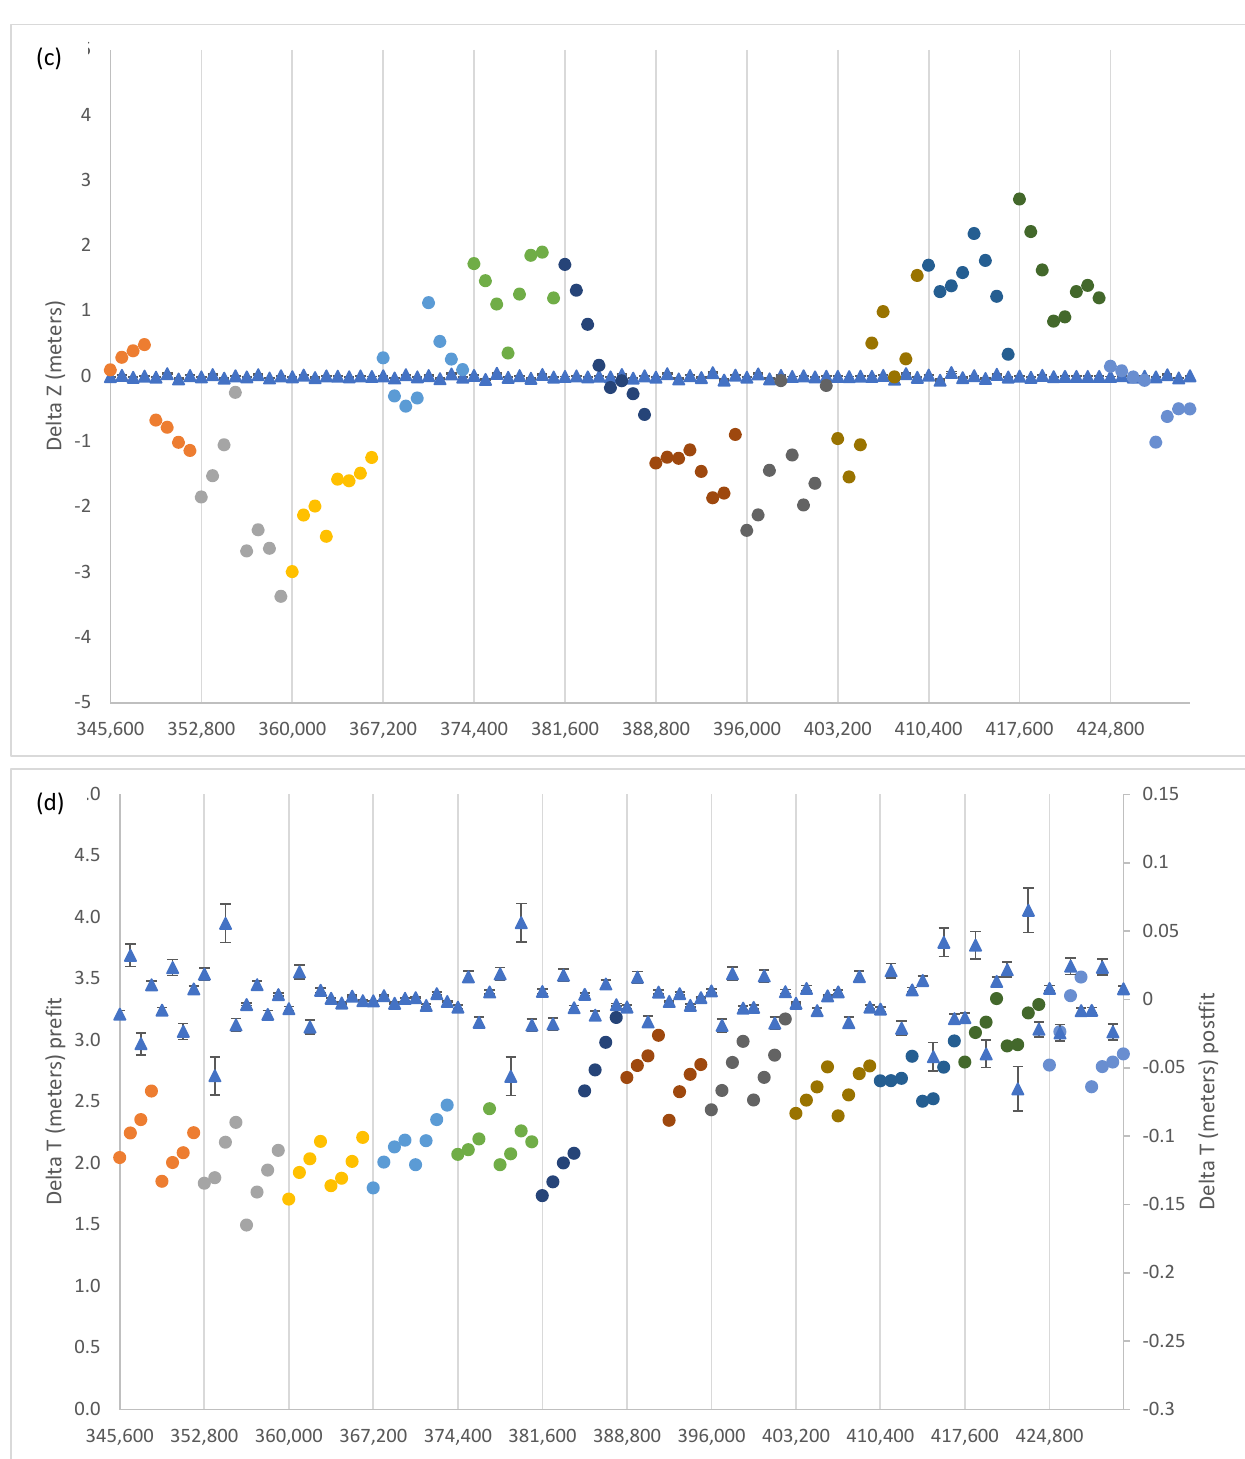
Figure 11. Pre-fit (dots) and post-fit (diamonds) residuals of ( a ) X, ( b ) Y, ( c ) Z, and ( d ) T for R01. Length of arc for fit is 1 h. Different colours denote different ephemeris blocks.